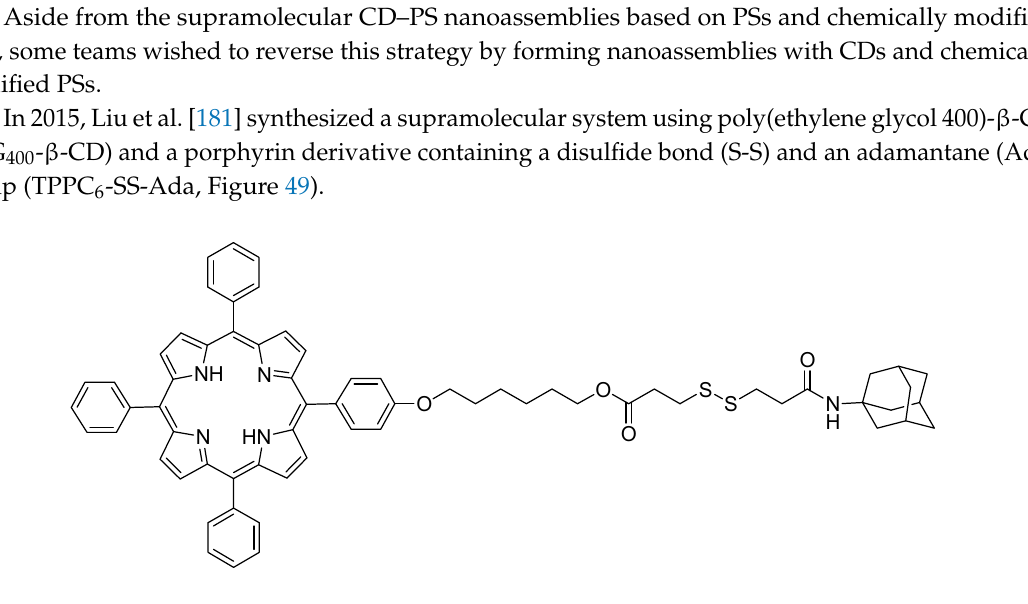
Figure 49. Chemical structure of a porphyrin derivative containing a disulfide bond (S-S) and an adamantane (Ada) group (TPPC 6